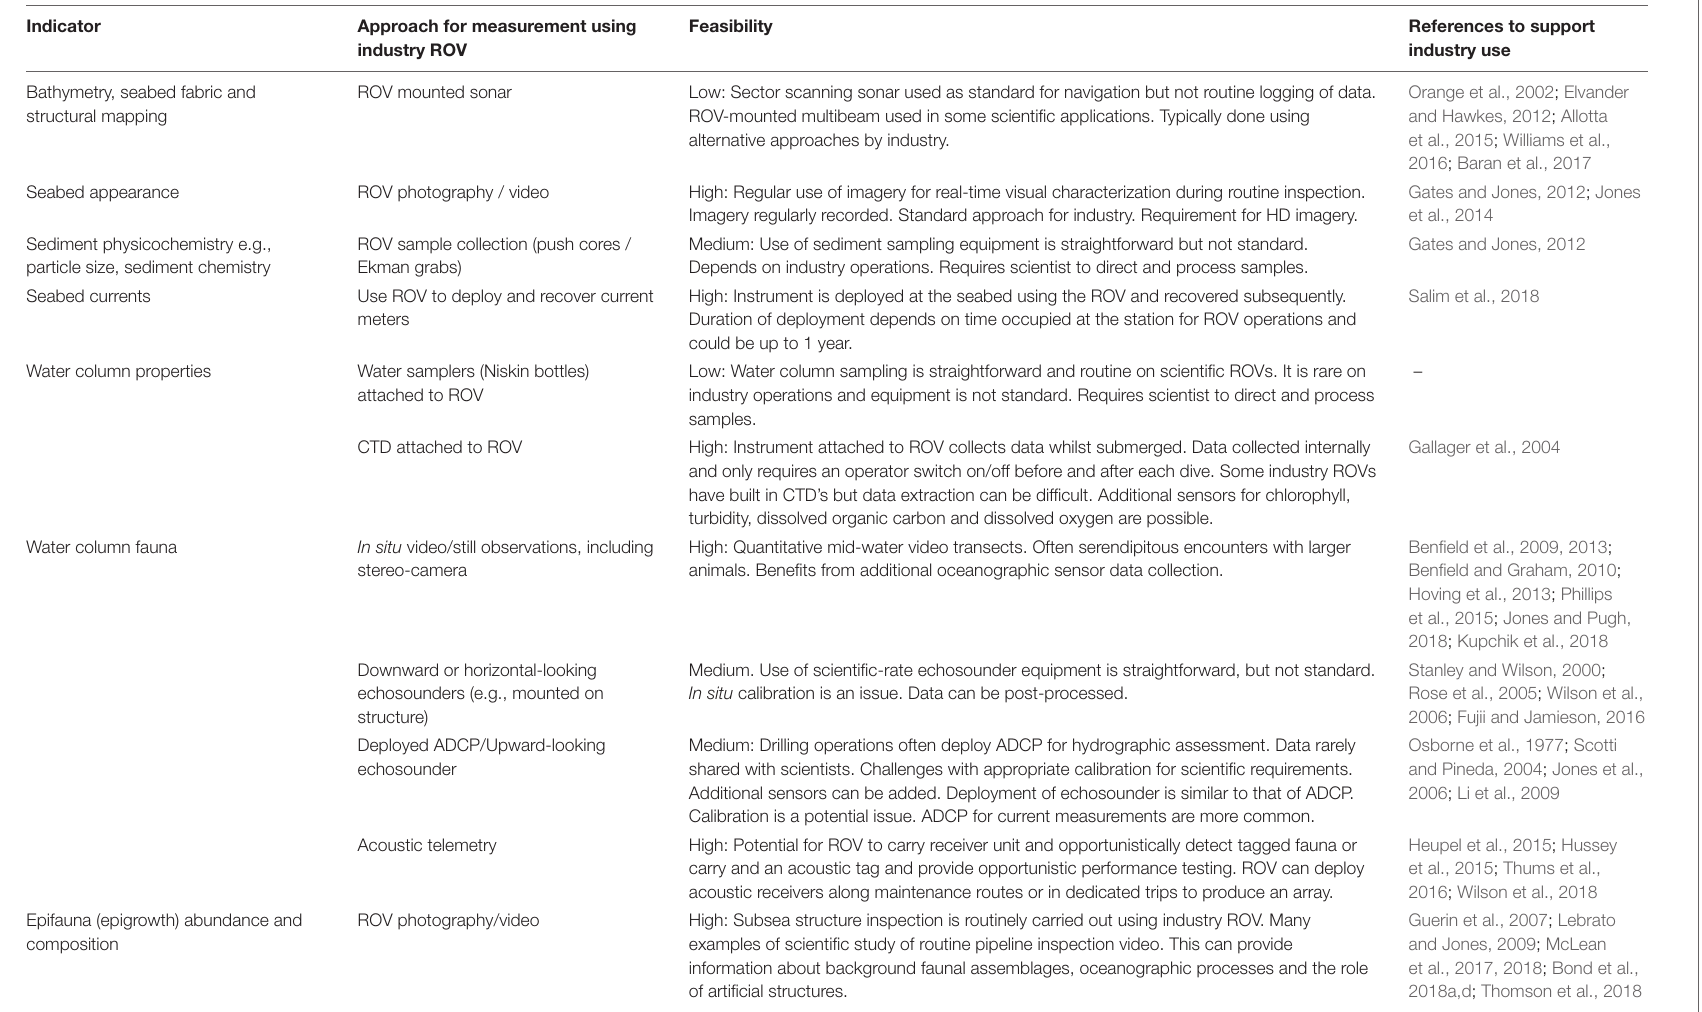
TABLE 1 | Key environmental indicators for assessment and the approach for obtaining them using industry ROV.